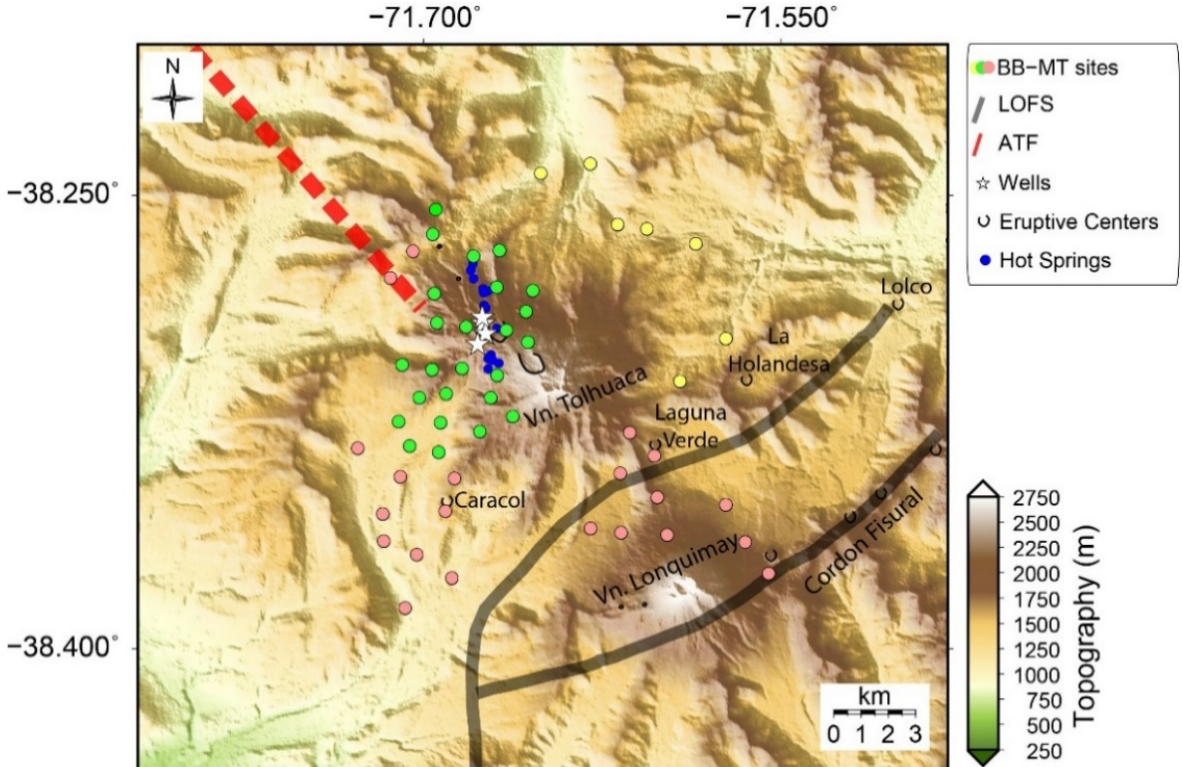
Figure 2. Topographic map of the study area. The highest elevations correspond to the summits of Tolhuaca and Lonquimay volcanoes. Caracol, La Holandesa, Laguna Verde, and Lolco pyroclastic cones aligned WNW-ESE are located between the two major summits [32]. Yellow, green, and pink circles show locations of the 2007, 2014, and 2019–2020 magnetotelluric sites used for this study. White stars indicate wells. Black lines outline the eruptive centers. Blue circles indicate hot springs. Elevation data were obtained from the SRTM1 Global relief model (www.ngdc.noaa.gov/mgg/global/global.html, accessed on 28 November 2022).